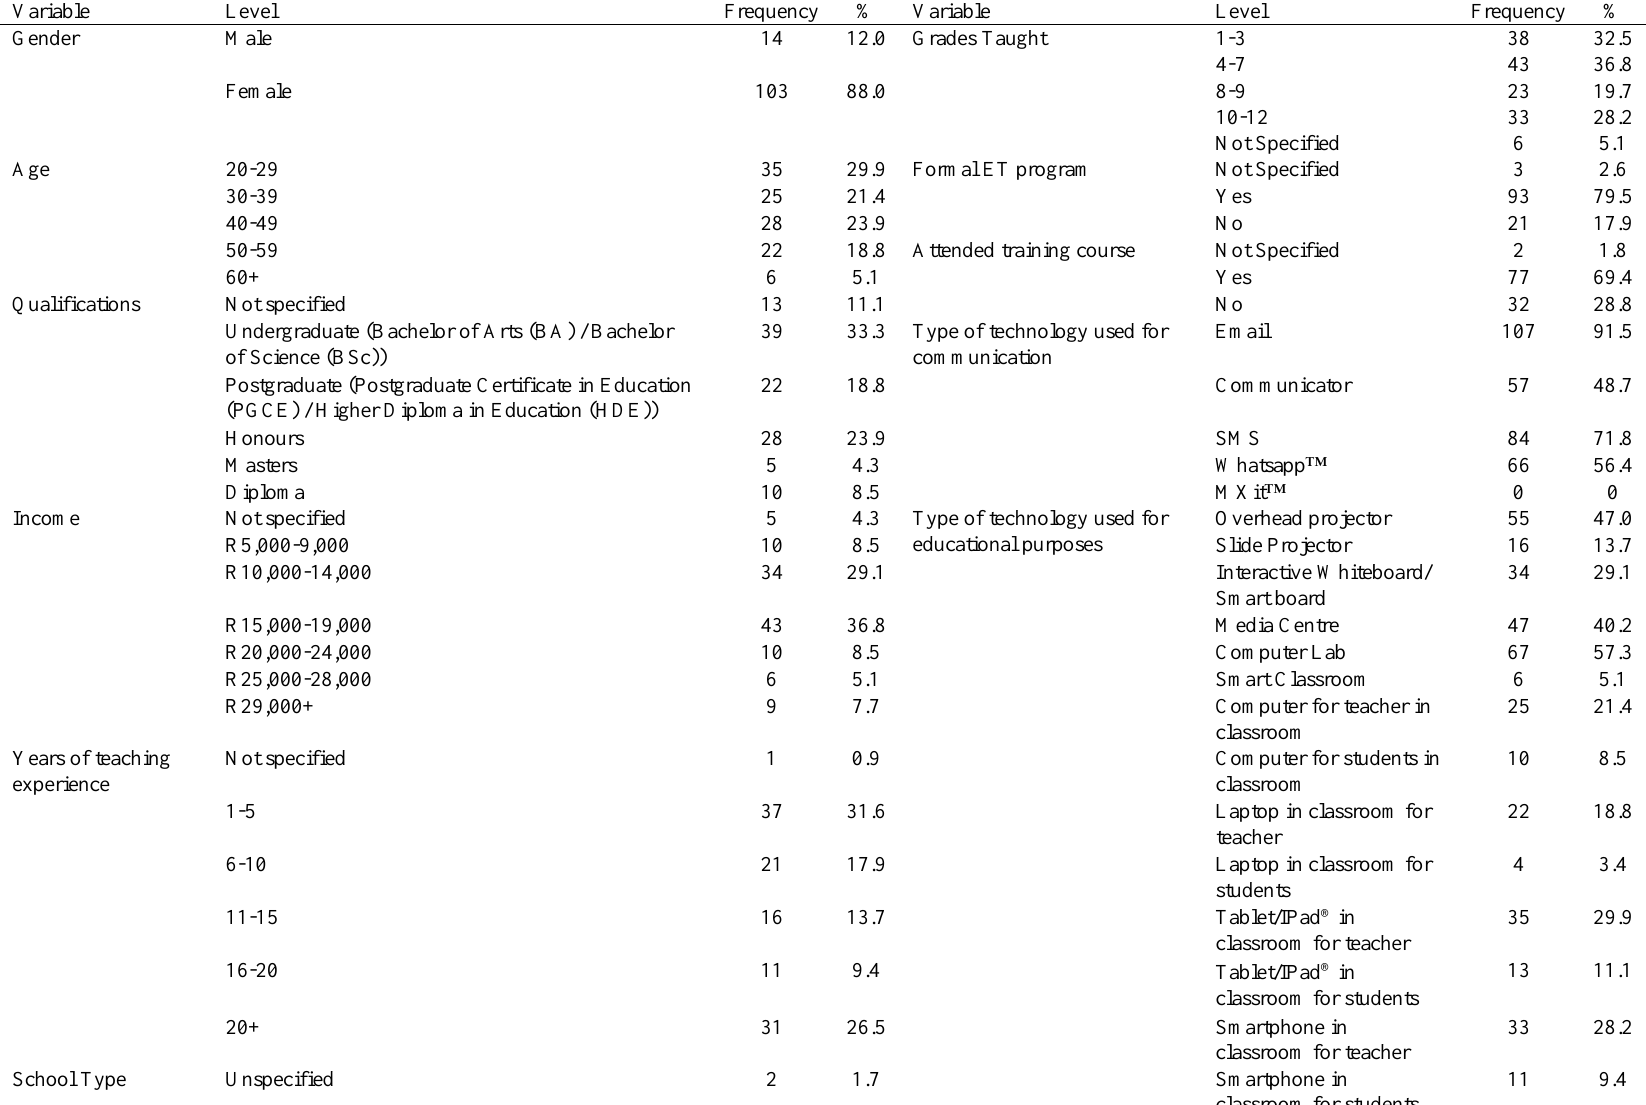
Table 1 Demographic description of